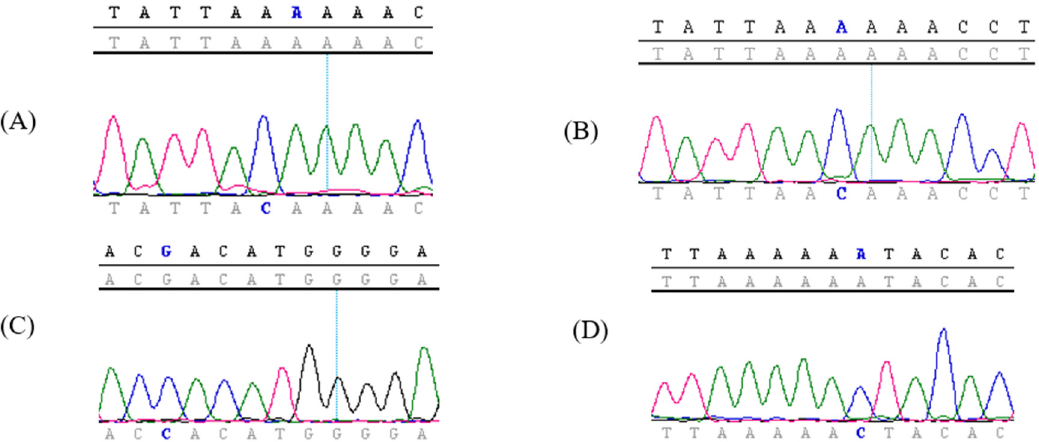
Figure 2. Novel mutations detected in the study population. ( A ) In specimen 219, A5796C led to changing lysine in position 53 to threonine (K53T). ( B ) In specimen 184, A5797C led to changing lysine in position 53 to asparagine (K53N). ( C ) In specimen 163, G6732C led to changing arginine in position 365 to proline (R365P). ( D ) In sample 136, A6967C led to changing lysine in position 443 to asparagine